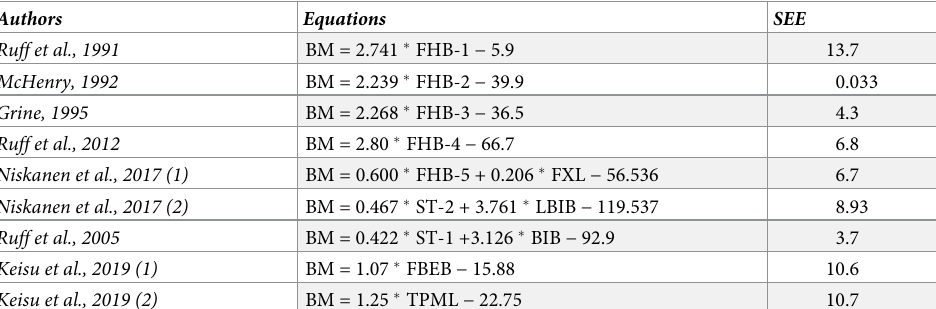
Table 1. Regression equations of body mass estimation that were used in this study, and their SEE (standard error of the equations, as reported in the quoted studies).